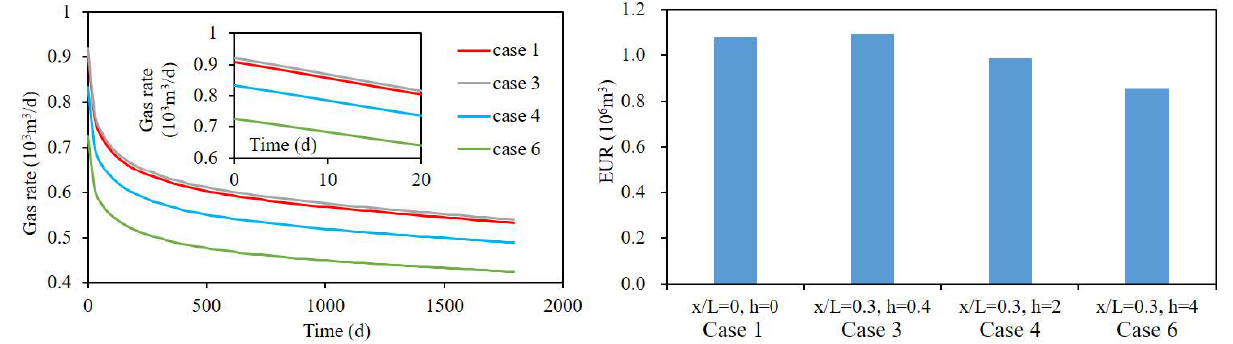
Figure 11. Effect of water film thickness on gas well production, the subfigure is the magnification of the intersection with the ordinate.